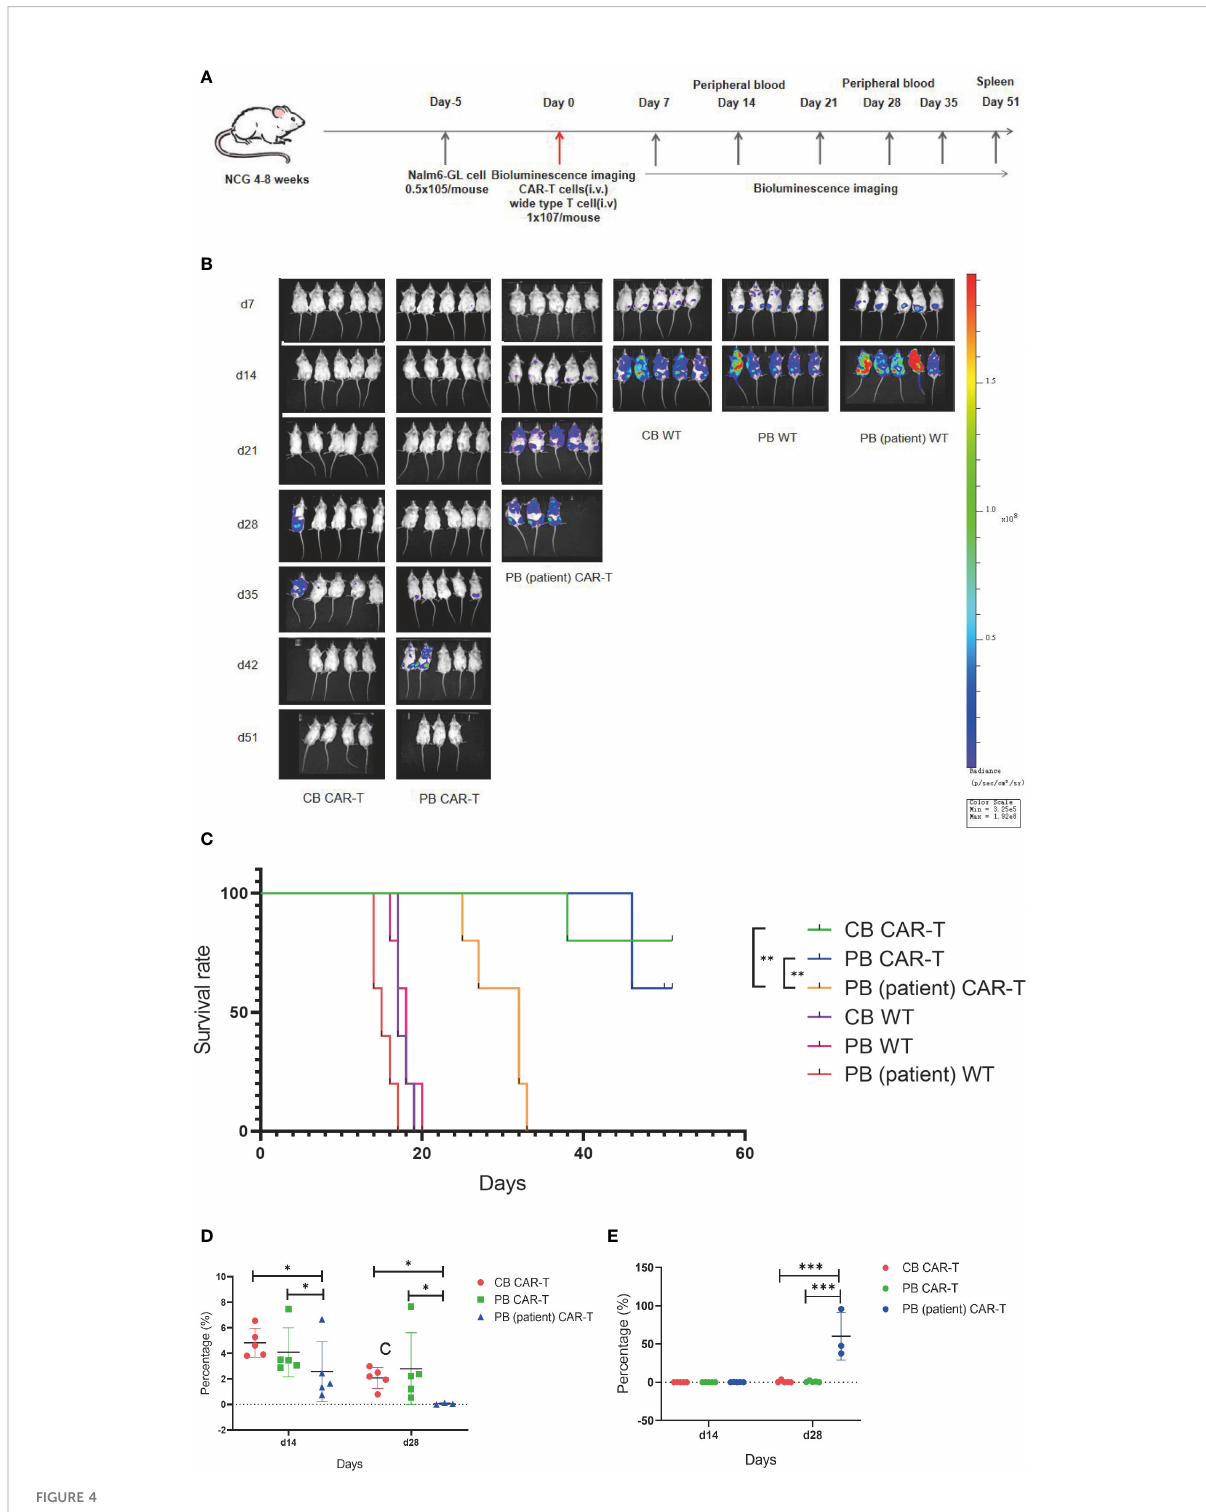
FIGURE 4 CB CAR-T and PB CAR-T had better antitumor ef fi cacy in vivo . (A) Flow chart of the in vivo experiment. (B) Bioluminescence imaging of NALM6-GL-burdened mice treated with the three groups of CAR-T cells and control T cells. (C) Survival analysis of mice treated with the three groups of CAR-T cells and control T cells. (D) Proportions of CAR-T cells in the peripheral blood of mice on days 14 and 28. (E) Proportions of tumor cells in the peripheral blood of mice on days 14 and 28. *p < 0.05, **p <